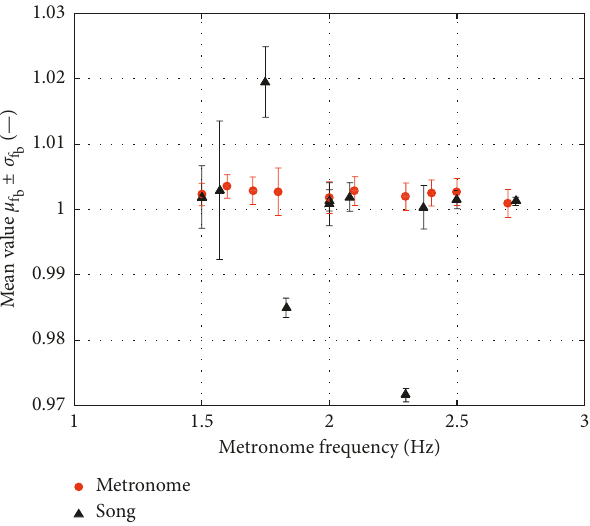
Figure 38: Comparison of the normalized achieved bouncing frequency for auditory stimuli.